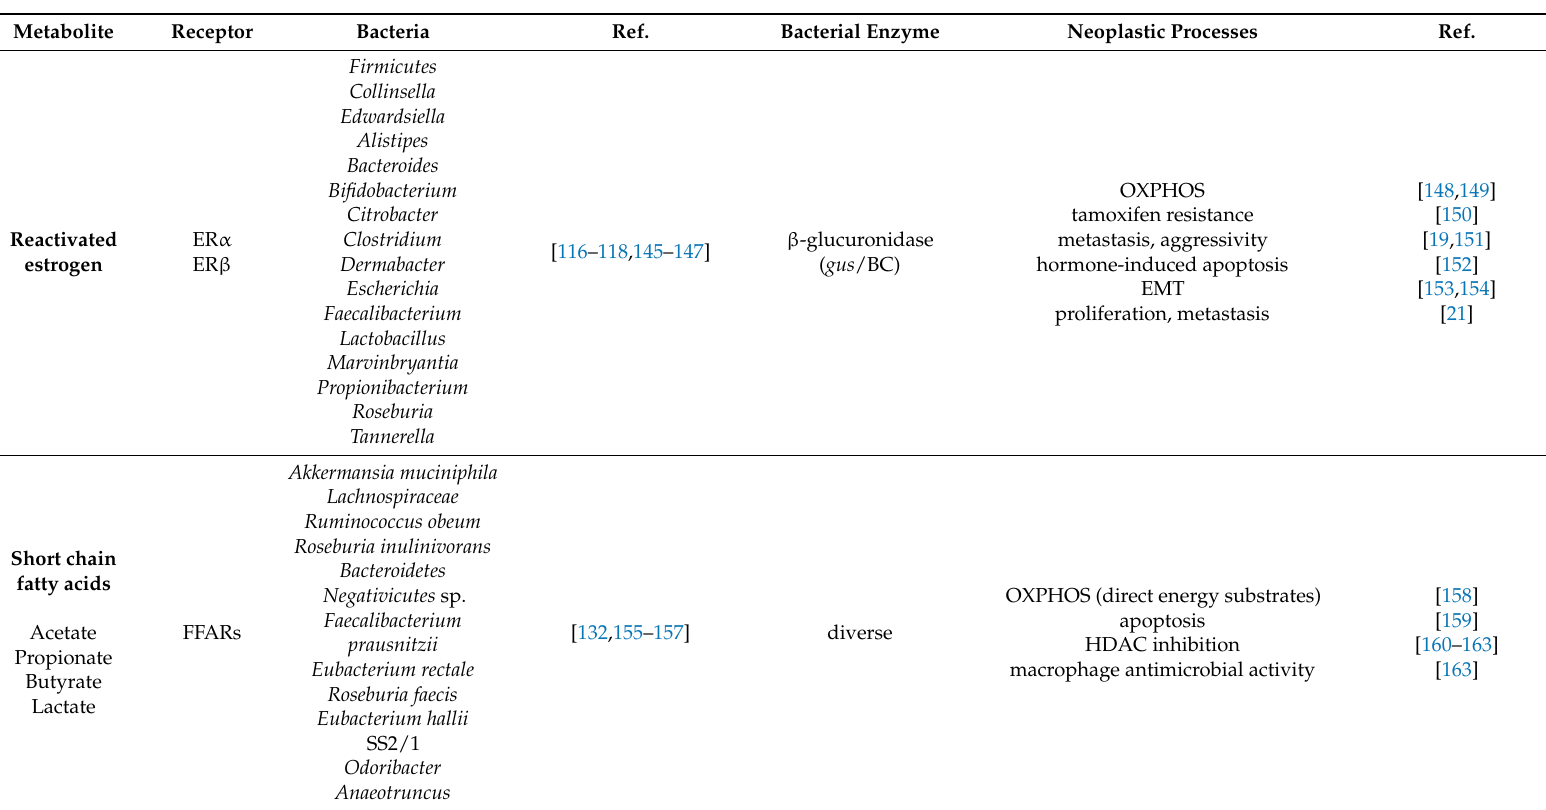
Table 4. Effects of the bioactive bacterial metabolites in breast cancer. Processes in green are upregulated by the metabolite, in red those, that are downregulated. Black text stands for ambiguous data. Abbreviations: ER–estrogen receptor; FFAR–free fatty acid receptor; TGR5/GPBAR1–G protein-coupled bile acid receptor 1; FXR–farnesyl X receptor; TAAR–trace amine-related receptor; OXPHOS–oxidative phosphorylation; EMT–epithelial-to-mesenchymal transition; HDAC–histone deacetylase; CSC–cancer stem cell; VEGF–vascular endothelial growth